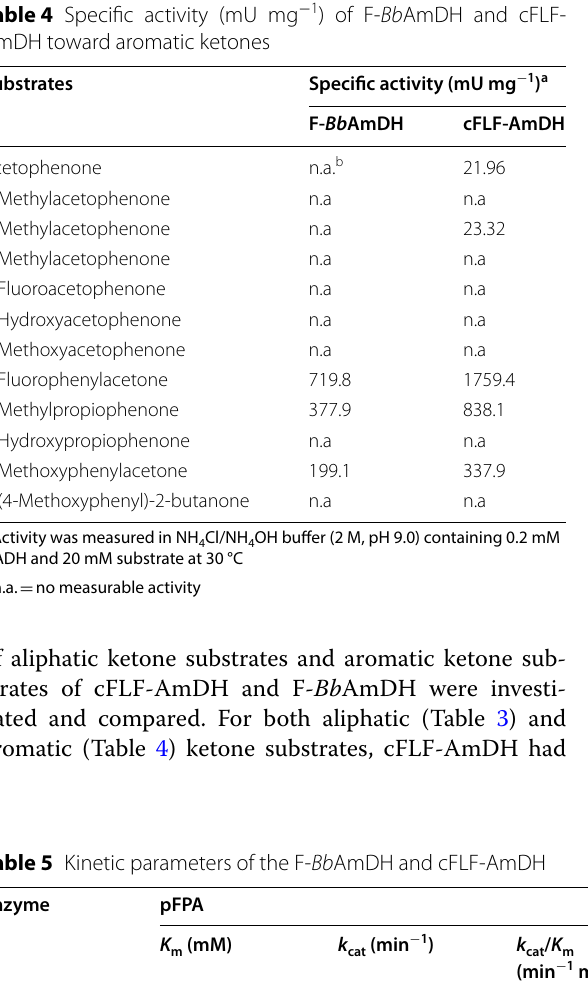
The values were generated by fitting the initial specific activity data to the Michaelis–Menten equation using nonlinear regression with GraphPad Prism software. Value is means standard deviations. All reactions involved in the kinetic constant calculations were analyzed using a 2 M NH 4 Cl/NH 4 OH buffer at optimum pH and ± temperature. All experiments were repeated 3